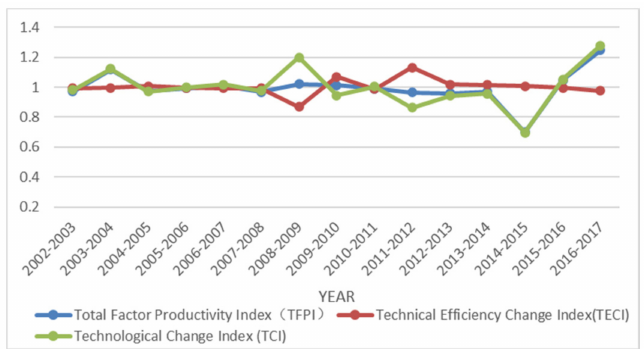
Figure 6. National average total factor productivity index (TFPI), technical efficiency change index